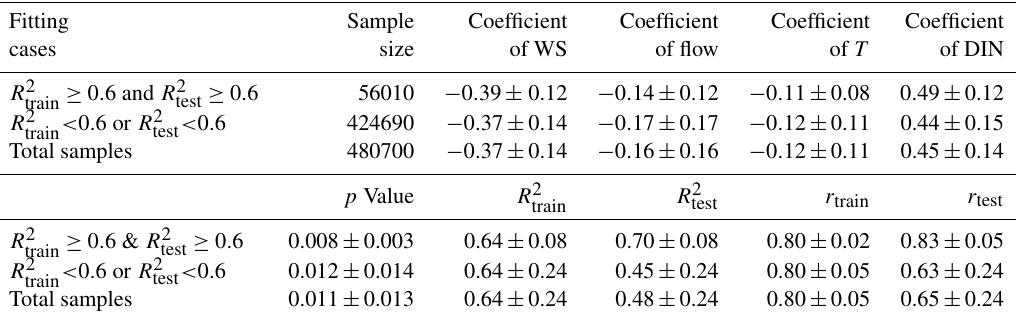
Table A4. Regression coefficients of wind speed (WS), freshwater discharge (flow), bottom temperature ( T ), and surface dissolved inorganic nitrogen (DIN) of different sample datasets (mean ± SD); R 2 and Pearson correlation coefficient ( r ) of training and testing dataset in different sample datasets (mean ±